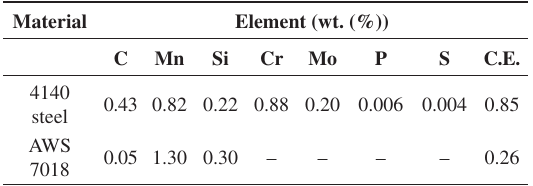
Figure 1. (a) welded joint obtained by the SMAW process, (b) schematic representation of the welded plates, and (c) fatigue specimen used in this study. Table 1. Chemical composition of the base and filler metals (in wt.